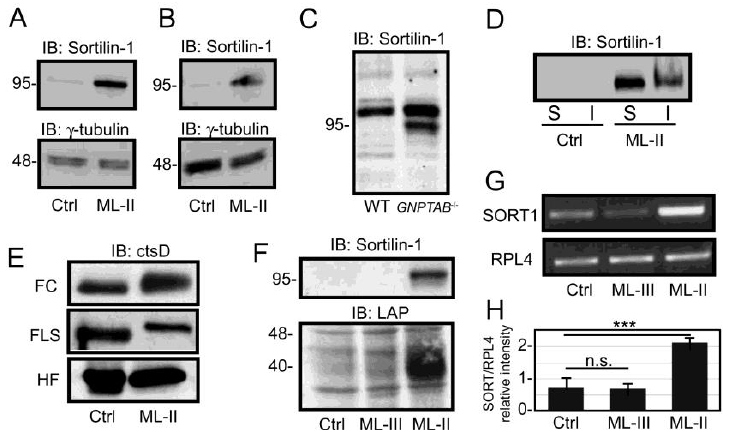
Figure 5. Sortilin-1 protein and transcript levels are elevated in ML-II but not ML-III, fibroblasts. Western blots for sortilin-1 in control and ML-II human fibroblasts ( A ) and feline fibroblast-like synoviocytes ( B ) using a mouse monoclonal antibody against human sortilin-1 (n = 3). ( C ) Sortilin-1 Western blot in WT and GNPTAB-/- (KO) HeLa cells (n = 2). ( D ) Sortilin-1 Western blot of DOC-soluble and –insoluble fractions of human control and ML-II fibroblasts (n = 3). ( E ) Western blot of control and ML-II feline chondrocytes (FC) and fibroblast-like synoviocytes (FLS) as well as control and ML-II human fibroblasts (HF) using a polyclonal antibody against human cathepsin D (n = 2). ( F ) Immunoblots for sortilin-1 and LAP in control, ML-III and ML-II human fibroblasts. Note the correlation of increased sortilin levels and accumulation of LAP in ML-II but not ML-III cells. ( G ) Representative reverse transcription-polymerase chain reaction (RT-PCR) analysis of sortilin-1 transcripts. Ribosomal Protein L4 (RPL4) transcript abundance is shown as a loading control. ( H ) Quantification of the intensity of SORT1 relative to RPL4 (n = 3), *** p ≤